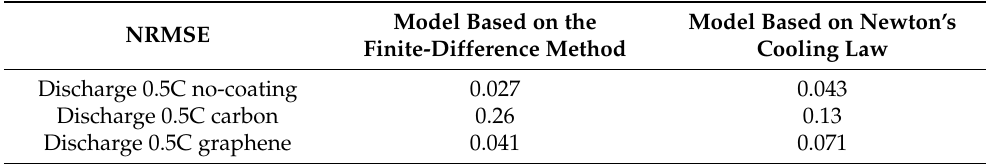
Table 7. NRMSE between experimental and modeled curves of temperature at discharge rate